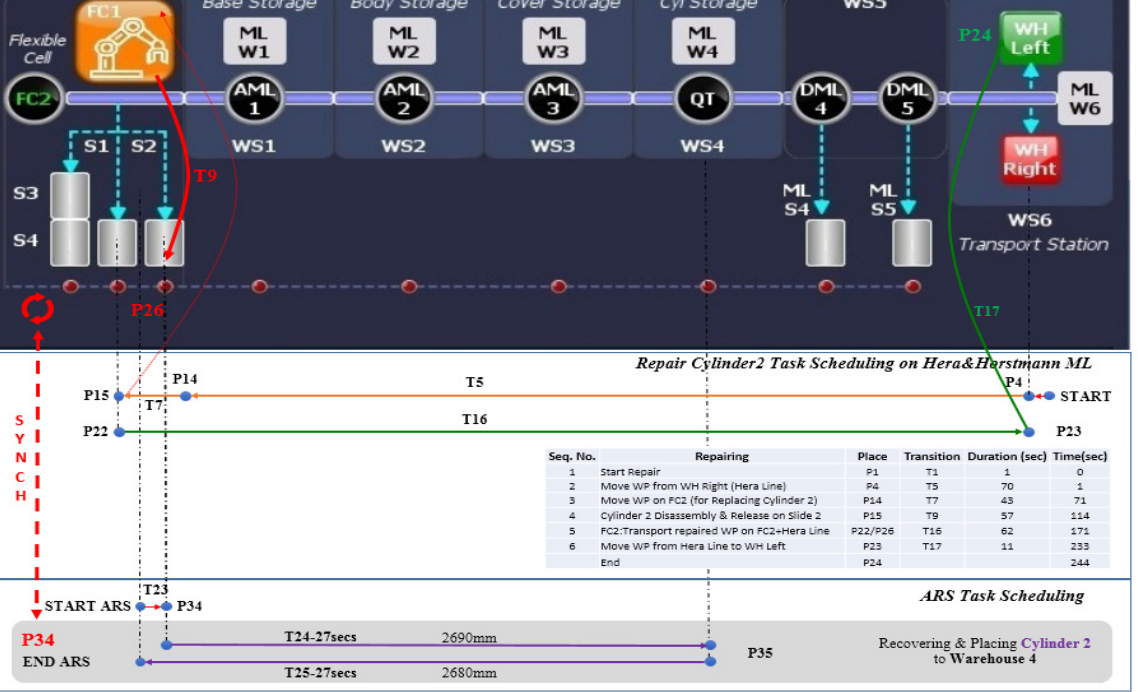
Figure 18. ARS task scheduling for repair/replace Cylinder